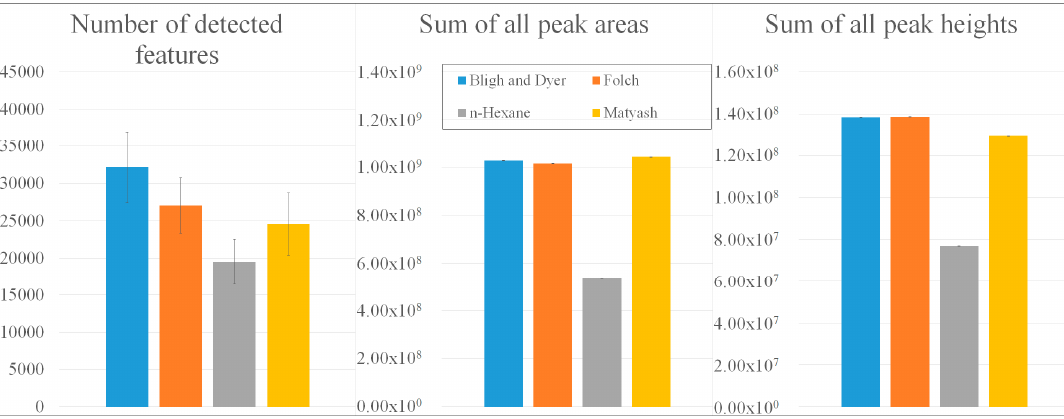
Figure 1. Comparison of extraction procedures according to Bligh and Dyer [22], Folch [23], Reis using n -hexane [25], and Matyash [24] with regard to the number of detected mass features, the sum of all peak areas, and the sum of all peak heights.